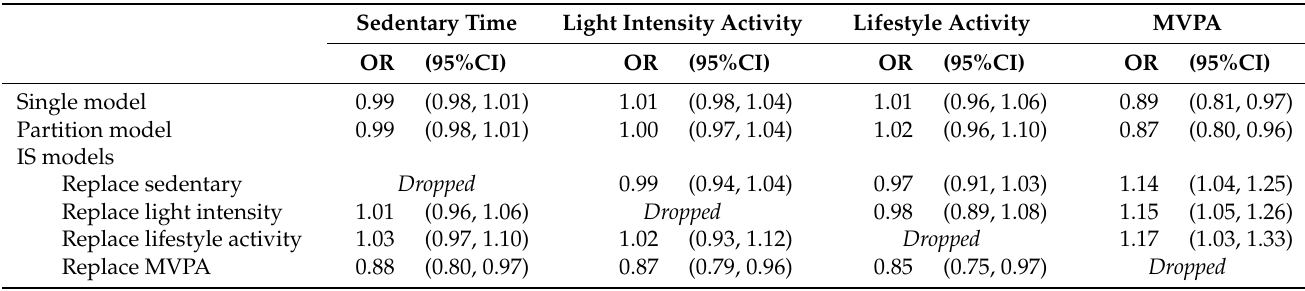
Table 3. Single factor, partition, and isotemporal substitution models examining the association of sedentary behavior, light and lifestyle, and MVPA with adverse cardiometabolic health ( ≥ 3 risk factors).